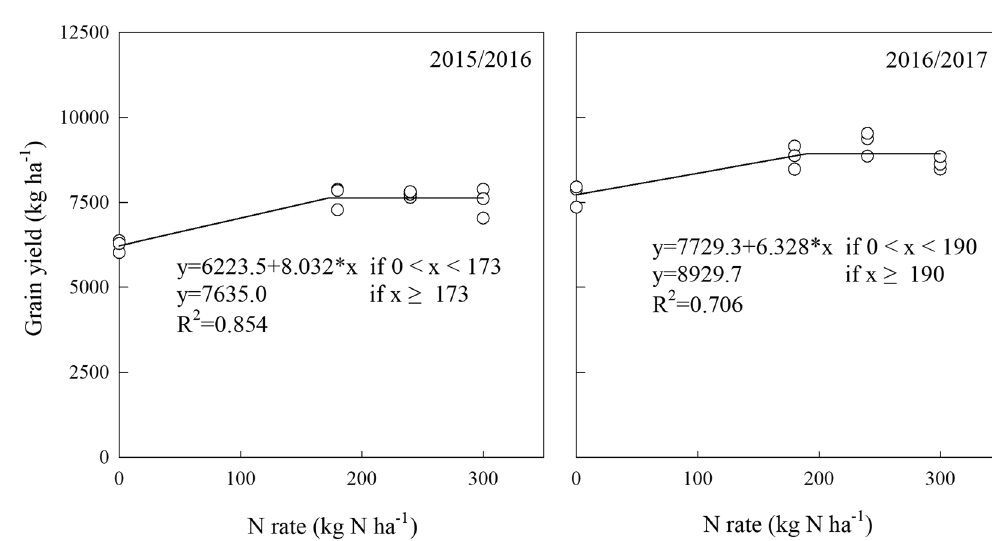
Figure 4. Linear-plateau model fitted for wheat yield as function of N application rate in 2015/2016 and 2016/2017.